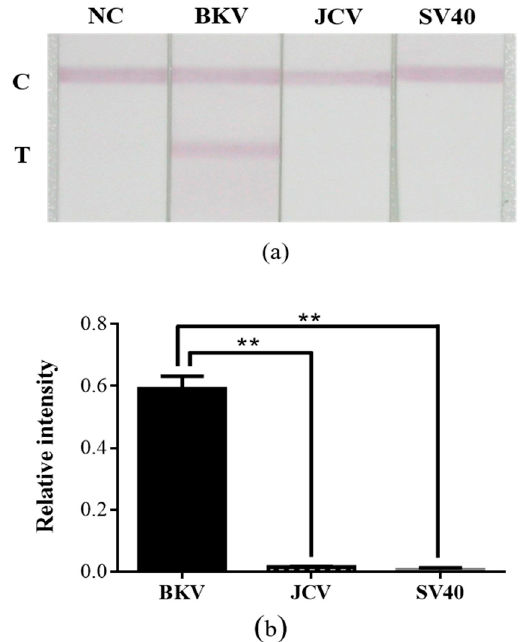
Figure 6. Specificity assay of the developed lateral flow strip. ( a ) Photographic images of the developed lateral flow strip in the presence of the various types of viral target DNA. ( b ) Relative intensity analyses of ( a ). The ** p < 0.01; data are presented as the mean and SD. NC: Negative control.